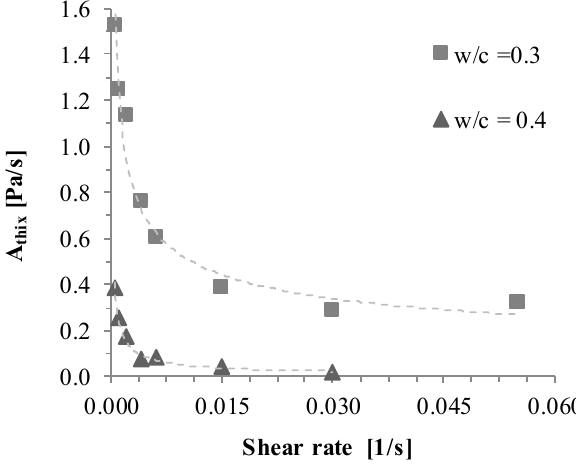
Figure 1. Residual structural buildup as a function of shear rate [36]. w/c: water-to-cement ratio.